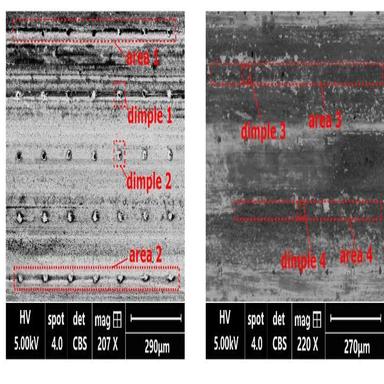
BSE images of the steel counter-surface textured with medium coverage (1.6%) of Type B (narrow & shallow) dimples in (a) run-in stage and (b) steady wear stage.